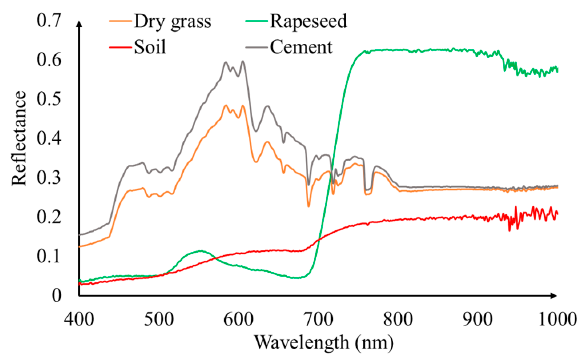
Remote Sens. 2019 , 11 , x FOR PEER REVIEW Figure 10. Reflectance curves of di ff erent ground objects. Figure 10. Reflectance curves of different ground objects.